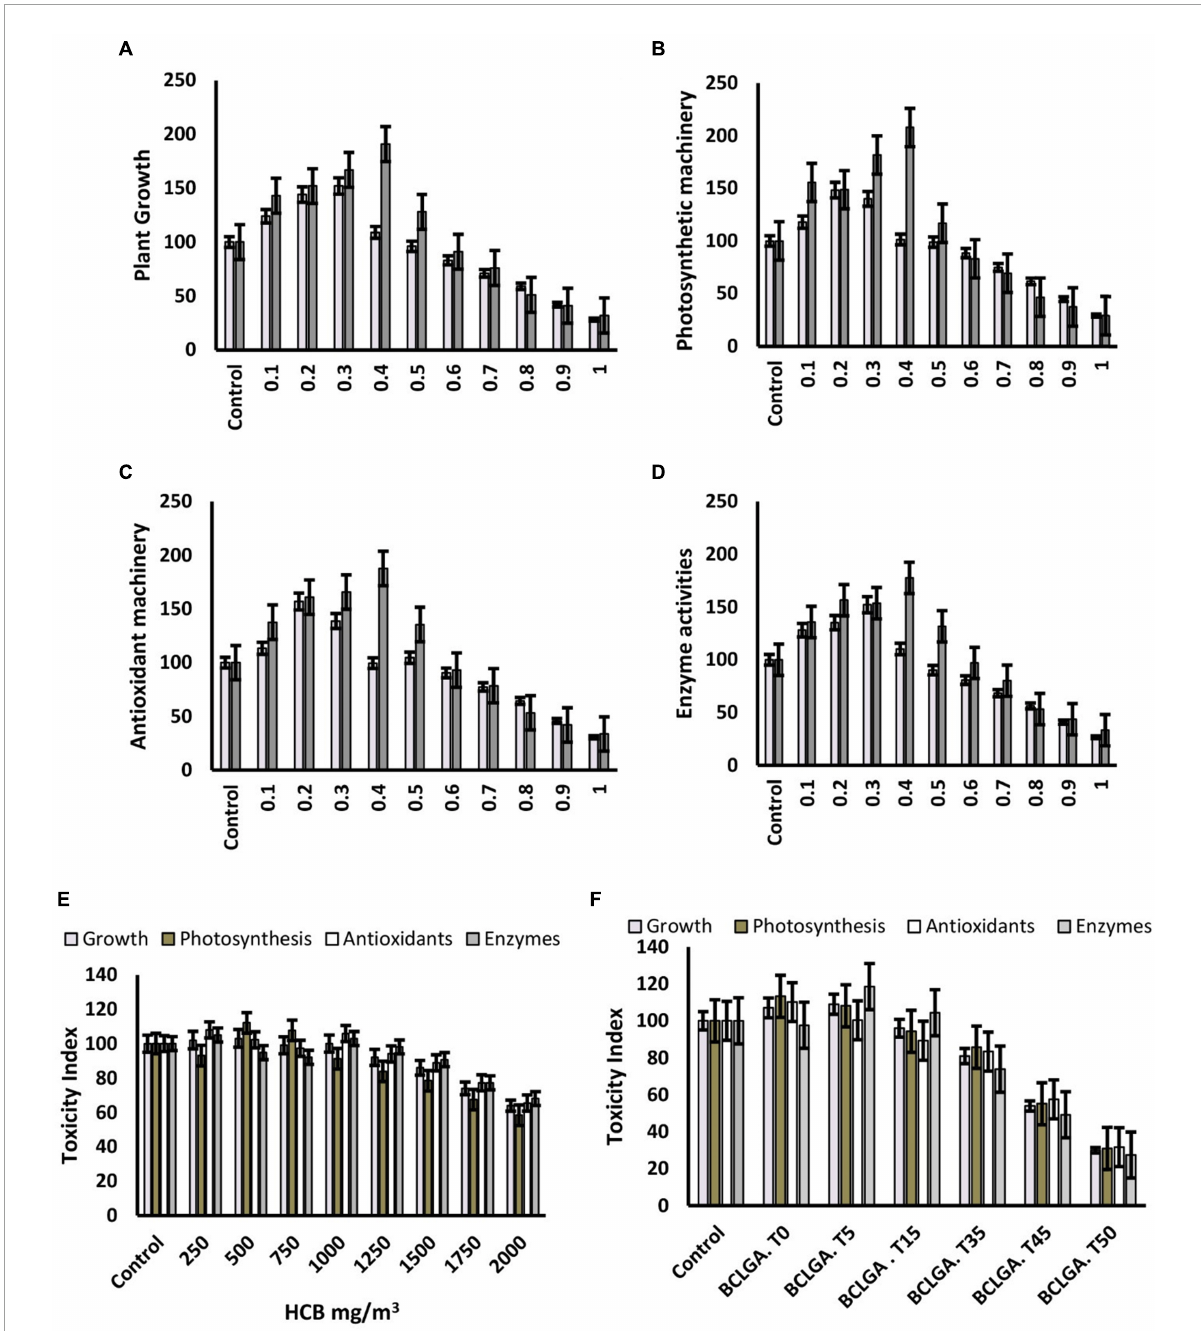
FIGURE4 Nanotoxicity assessment of bioclay nanoparticles alone and in combination with gibberellic acid on Brassica alboglabra plant growth (A) , photosynthesis (B) , antioxidant machinery (C) , and enzyme activities (D) . The relation of nanotoxicity of bioclay under ambined application with gibberellic acid with HCB (E) , and temperature (F) . Values demonstrate means ± SD ( n = 5). Different letters indicate a significant difference among the treatments ( P ≤ 0.05). T0 = 0 ◦ C, T05 = 05 ◦ C, T15 = 15 ◦ C, T35 = 35 ◦ C, T45 = 45 ◦ C, T50 = 50 ◦ C. All treatments without temperature tags got a continuous incubation temperature of 25 ◦